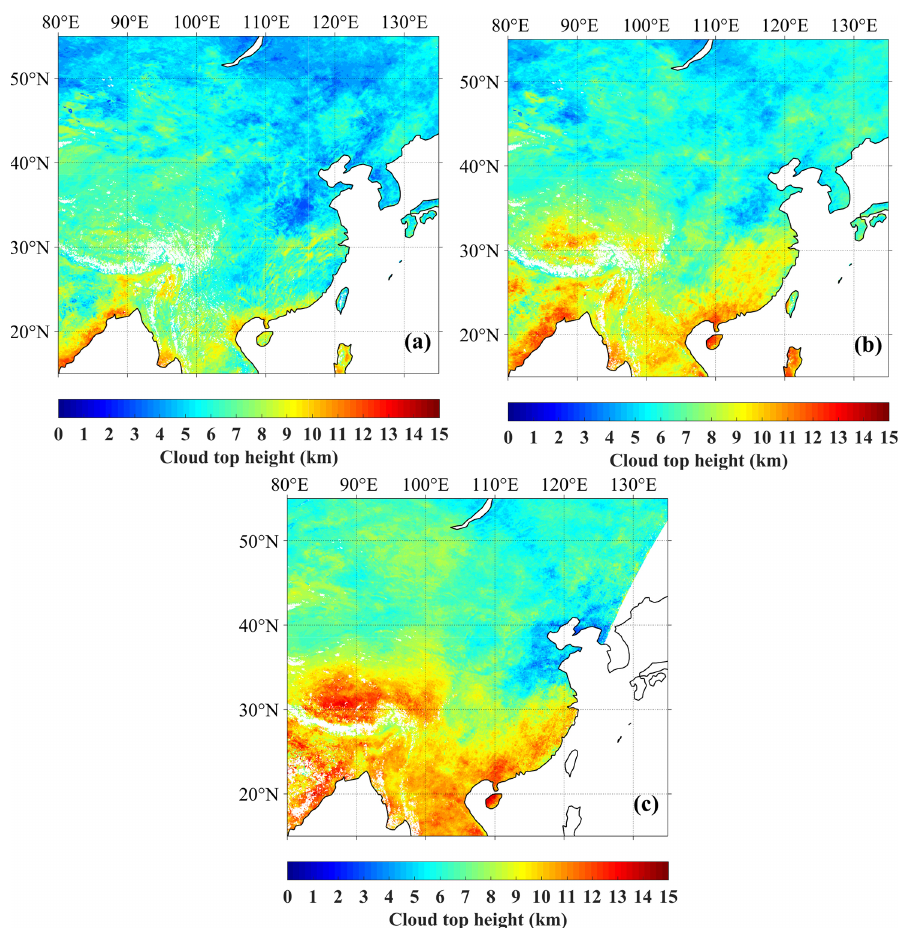
Figure 5. The median cloud top height derived from the Himawari-8 retrieval product at three Beijing times: (a) 14:30LT ± 0.5h, (b) 16:30LT ± 0.5h, and (c) 18:30LT ± 0.5h from June to August in 2016 over land in East Asia. Missing data are shaded in white